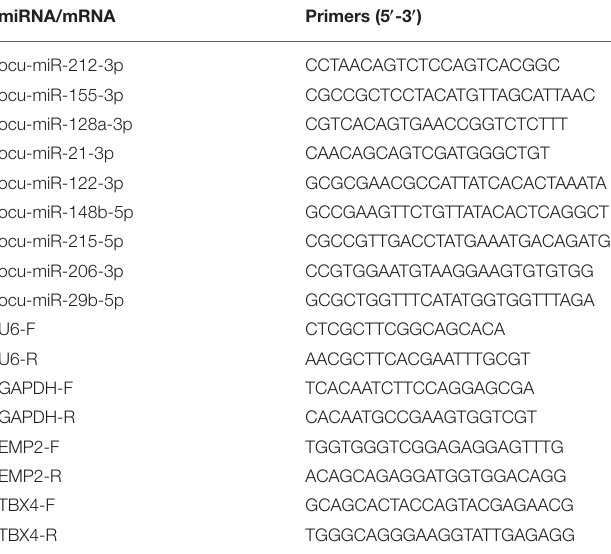
TABLE 1 | Primers sequences for the RT-qPCR confirmation of the selected miRNA and their target gene. miRNA/mRNA